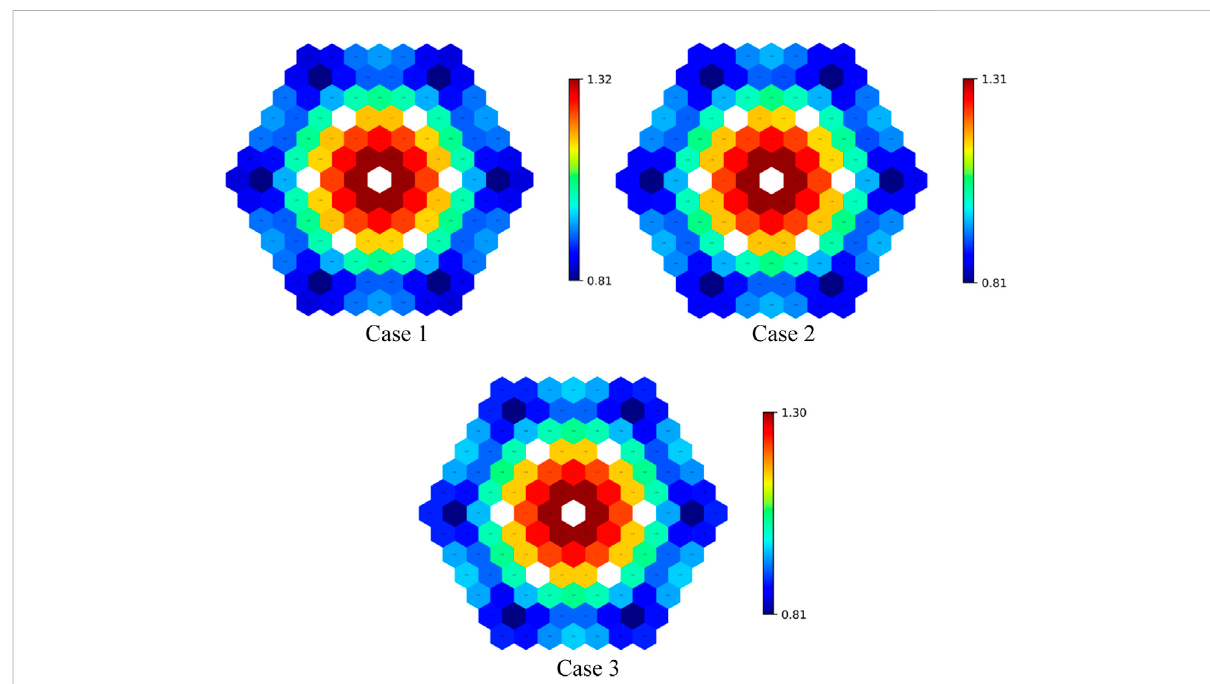
FIGURE 12 Assembly power distribution results on the beginning of life of the pitch-to-diameter ratio analysis.